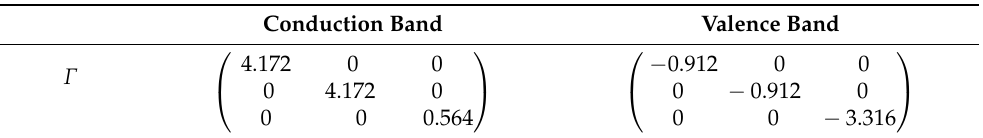
Table 2. Calculated effective mass of electron ( m e *) and that of hole ( m h *) in three principal directions at the Γ point. All values are in units of free electron mass ( m 0 ).